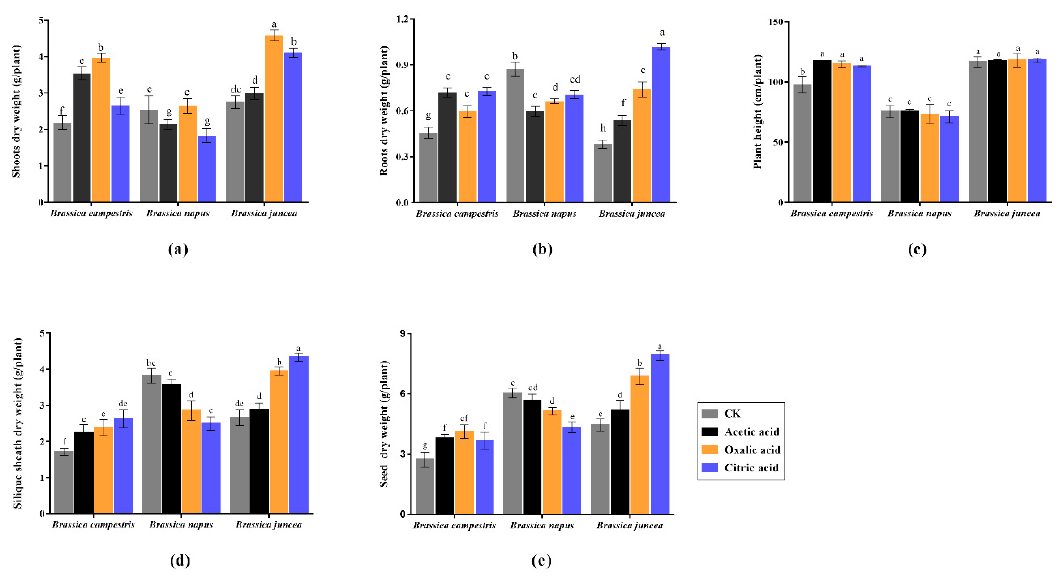
Figure 3. Plant characteristics at maturity stage of the three Brassica species grown in the presence of 20 mg/kg Cd and treated with organic acid. The Values are means ± SE from three biological replicates. Values followed by different letters indicate statistical significance based on two-way ANOVA ( p < 0.05). ( a ) Shoot dry weight. ( b ) Root dry weight. ( c ) Plant height. ( d ) Silique sheath weight. ( e ) Seed weight.